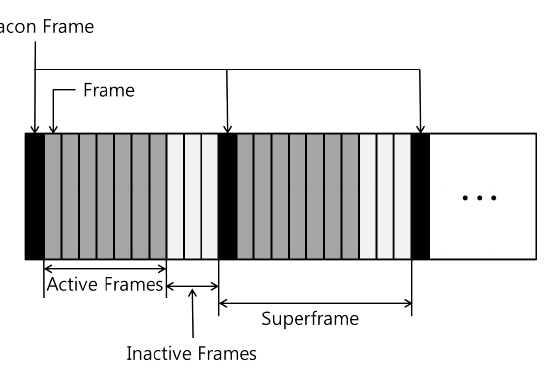
Figure 4. The structure of a superframe for VibeComm